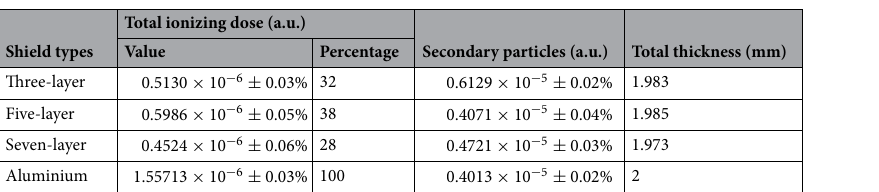
Table 3. Specifications of multi-layer radiation shields and aluminum.